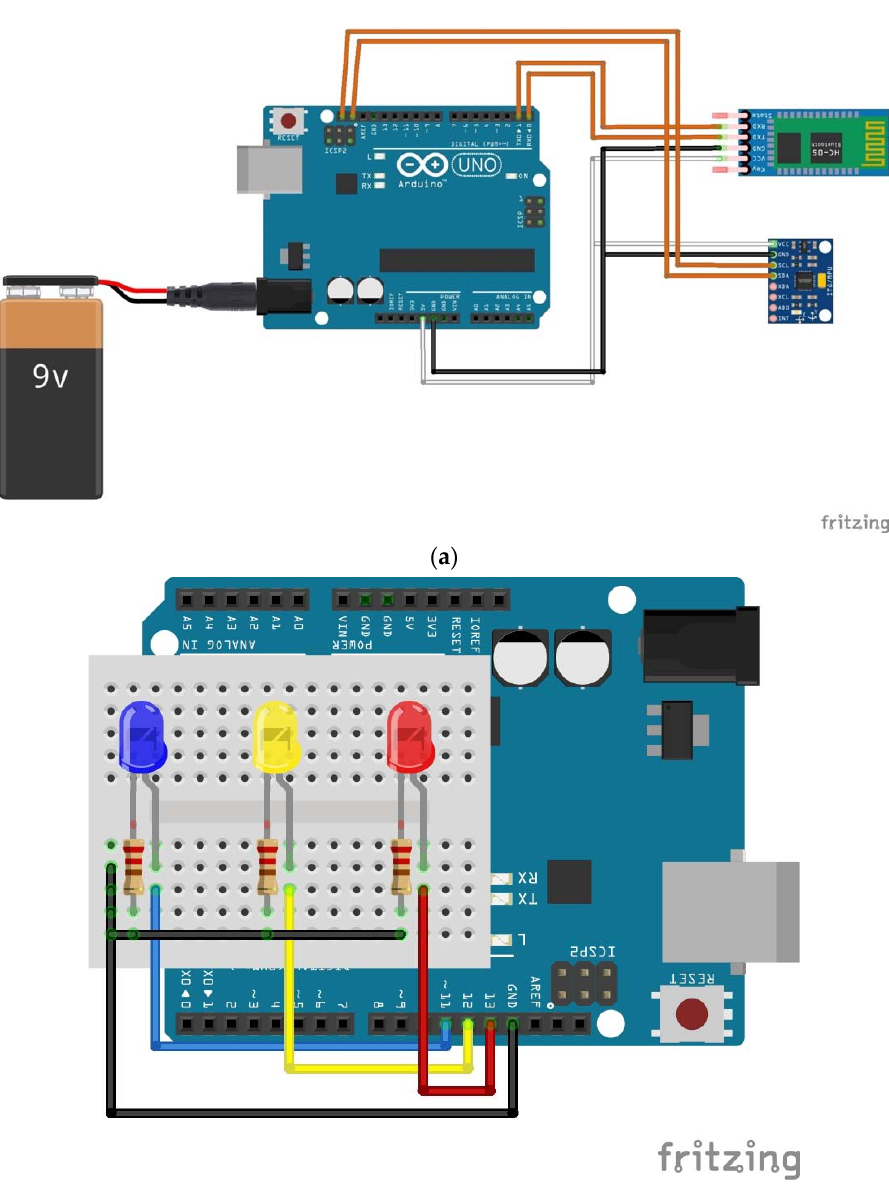
Figure 2. Schematic of Hardware Setup for ( a ) Sensor and ( b ) LEDs.